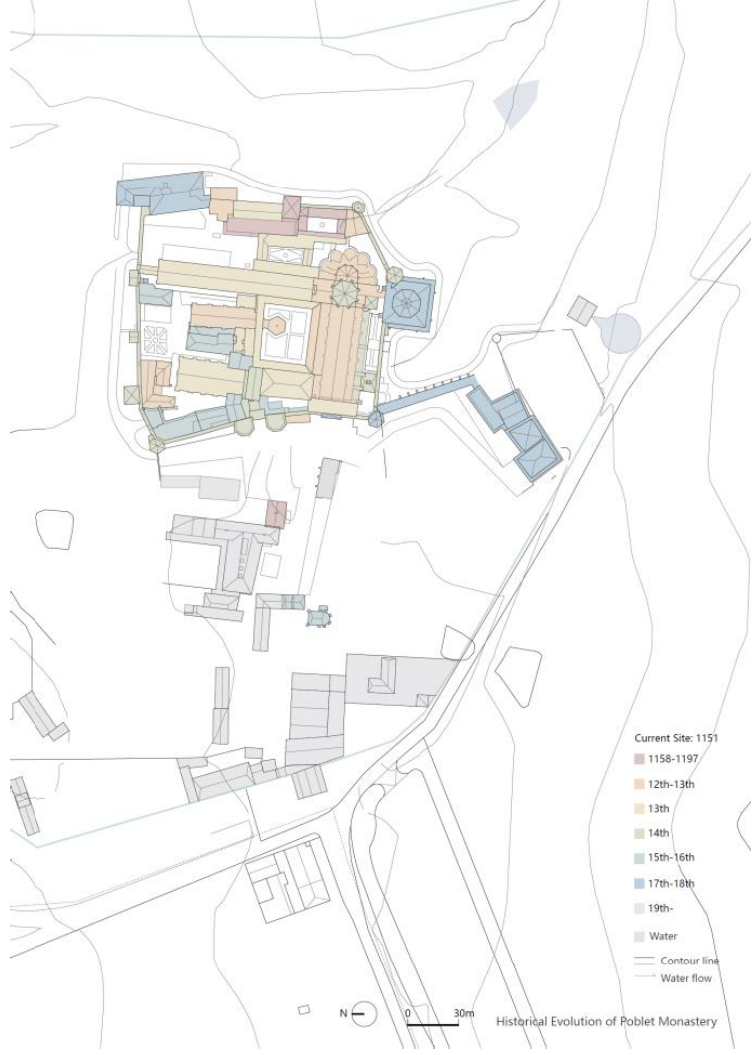
Figure 16. Historical evolution of Poblet Monastery.